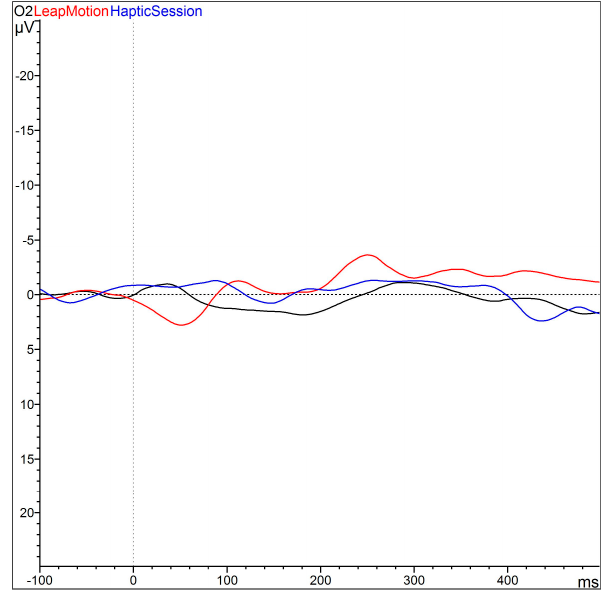
Figure 6. Grand average-matching ERP: black line represents the response of the task after motor imagery training; the red line represents the response after the task of Leap Motion training, and the blue line represents the response after haptic training.